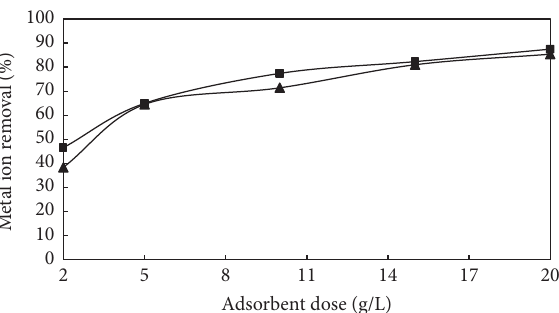
Figure 6: Percentage of Ni 2+ ( ◼ ) and Zn 2+ ( 󳵳 ) ions removal with varying adsorbent dose.